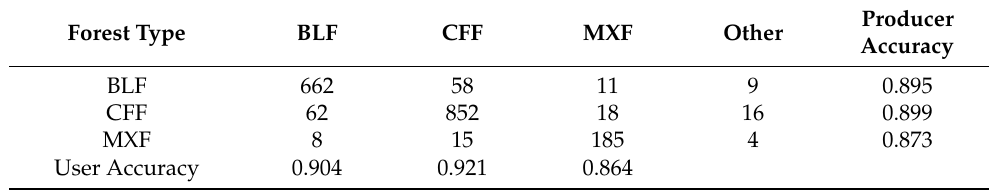
Table 2. The Land classification